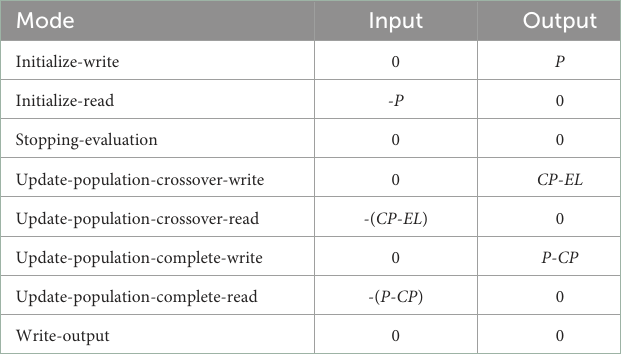
TABLE 2 Dataflow table for the GA Core